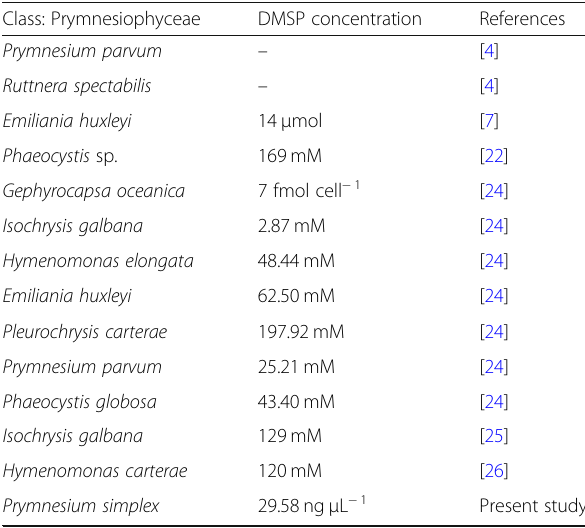
Table 1 Intracellular concentration of DMSP in marine cultures of prymnesiophyceae